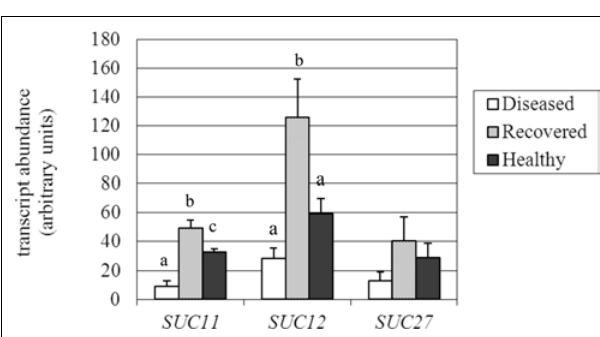
FIGURE 5 | Gene expression analysis of Vitis vinifera sucrose transporter (SUC) genes. Mean expression (MNE) values from at least three individuals for each plant group (H, D, R) plus standard errors are shown. Expression levels of the genes of interest are normalized to ubiquitin ( UBQ-L40 expression level = 100).When indicated, different letters denote significant differences ( P < 0.05).